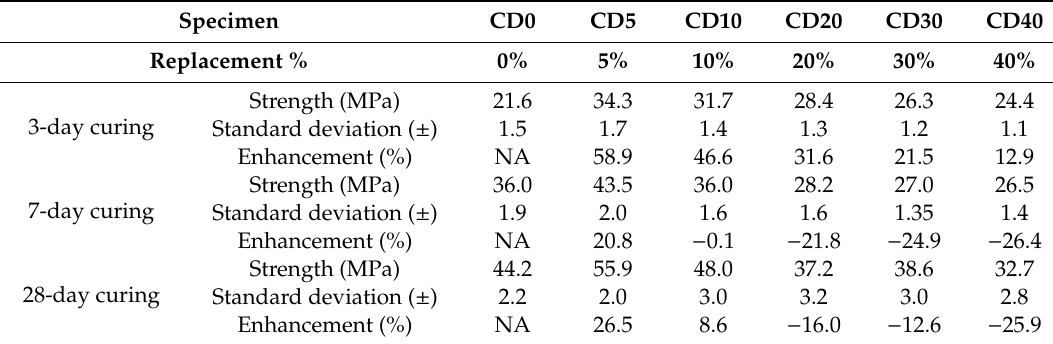
Table 5. Compressive strength results.